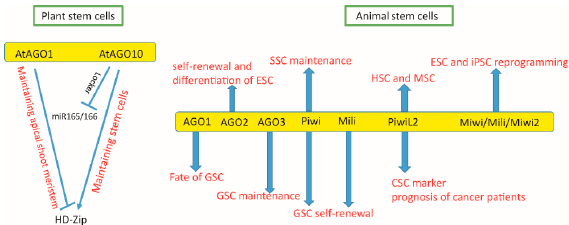
Figure 4. Summary of Argonaute proteins function in various stem cells.